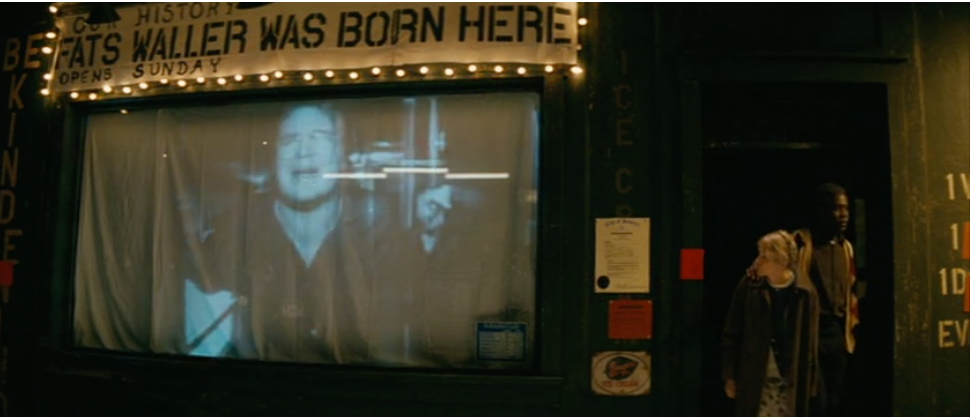
Figure 2. Miss Falewicz (Mia Farrow) and Mr Fletcher (Danny Glover) exit the store to investigate the commotion. Outside, the neighbourhood’s residents are enjoying Jerry’s (Jack Black) performance in their film, Fats Waller Was Born Here